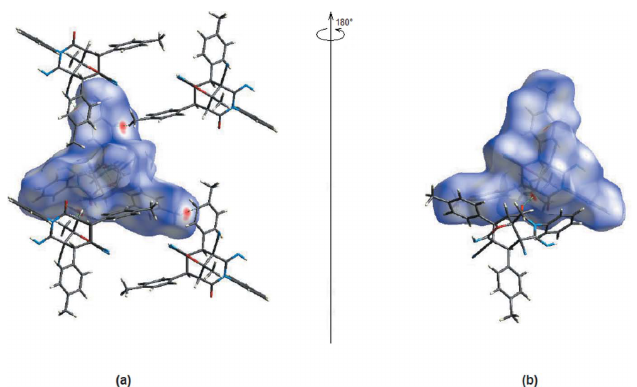
Figure 6 ( a ) Front and ( b ) back sides of the three-dimensional Hirshfeld surface of radii are represented as white spots. The most important red , z (cid:5) 3 ; (ii) x , (cid:5) y (cid:5) 1 , z (cid:5) 1 ]. 2 2 2 2 spots on the d surface represent the aforementioned C— norm H (cid:2) (cid:2) (cid:2) O and C—H (cid:2) (cid:2) (cid:2) N interactions (Tables 1, 2). Fig. 7 depicts the two-dimensional fingerprint plots of ( d d ) points from all the contacts contributing to the Hirshfeld e surface analysis in normal mode for all atoms. The most norm